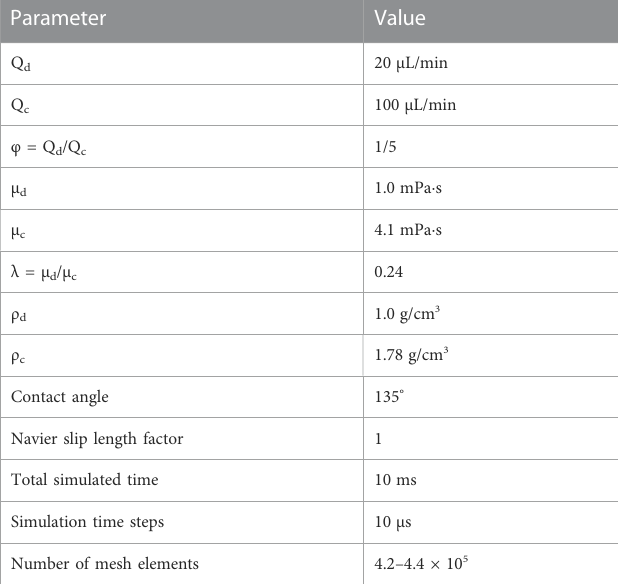
TABLE 1 Parameters used for